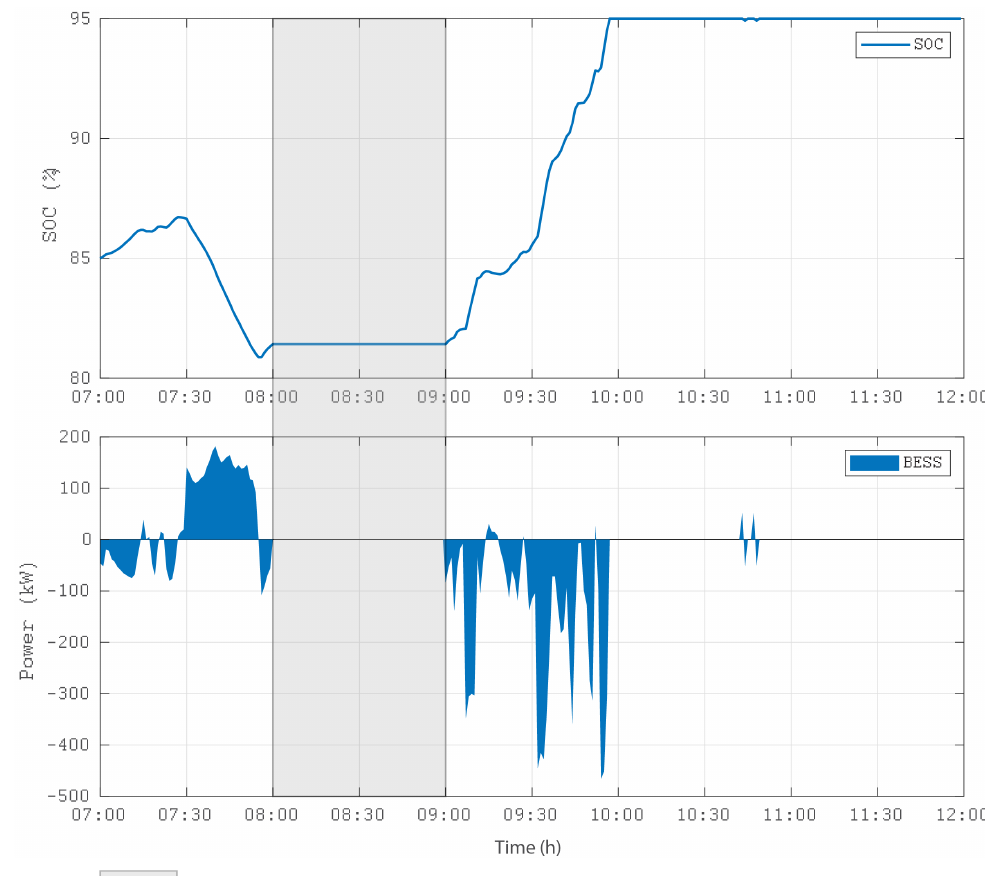
Figure 10. SOC variation and BESS injected/absorbed power for off-grid operation (case with BESS outage and PV plant limited to 50% of ASC demand).